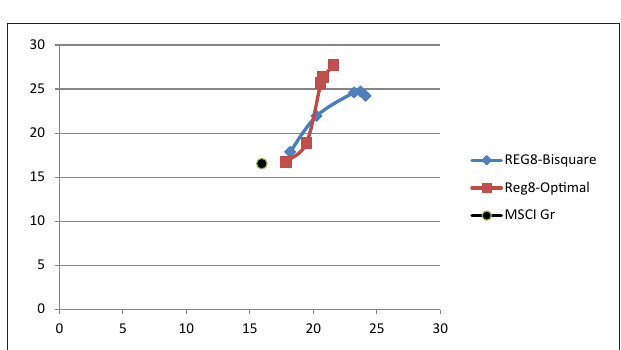
FIGURE 2 | Risk-return portfolios for alternative robust regressions,